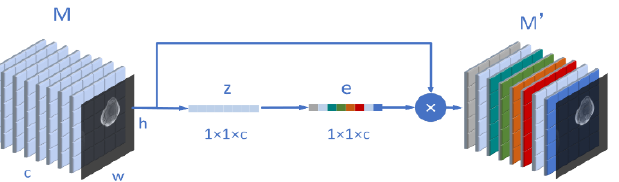
Figure 3. Schematic diagram of the structure of the attention mechanism involved in this